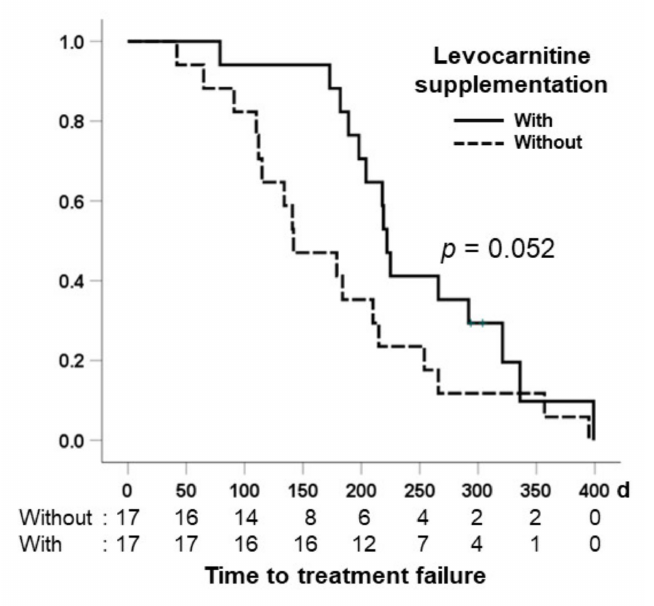
Figure 6. Comparison of the time to treatment failure between patients without and with levocarnitine